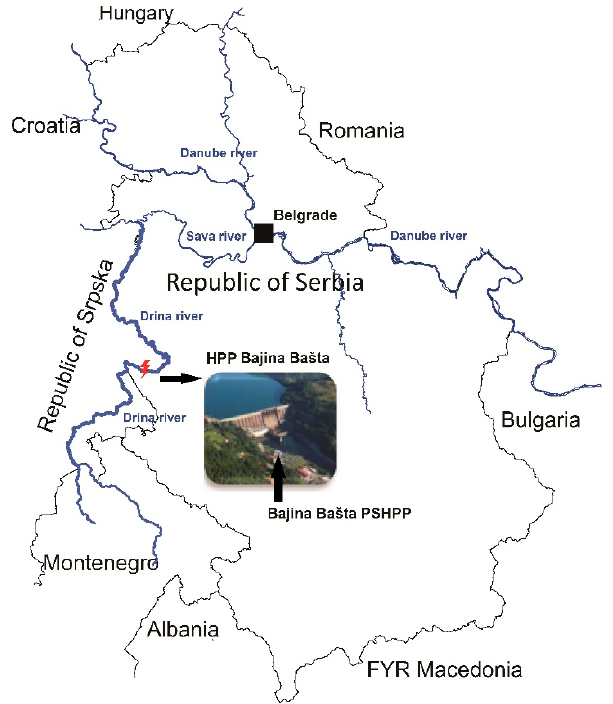
Figure 2. Map of Serbia showing the river Drina and the position of the PSHPP Bajina Bašta.